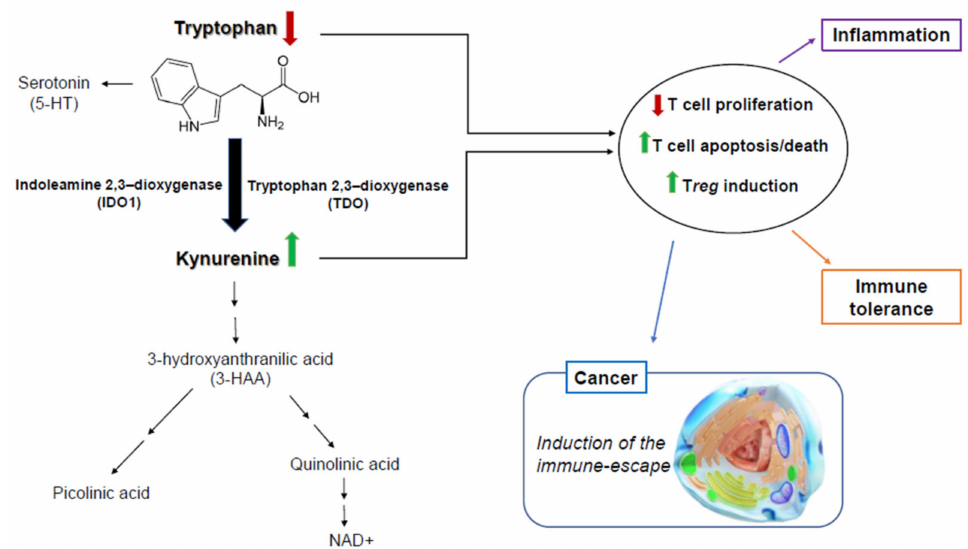
Figure 1. Tryptophan catabolism and kynurenine pathway. Indoleamine-2,3-dioxygenase (IDO1) and tryptophan-2,3- dioxygenase (TDO) pathways control T cell and T reg responses. IDO1—and TDO but to a lesser extent—are expressed on professional antigen presenting cells and tumor cells and are critical in immune regulation of cancers, infections, and